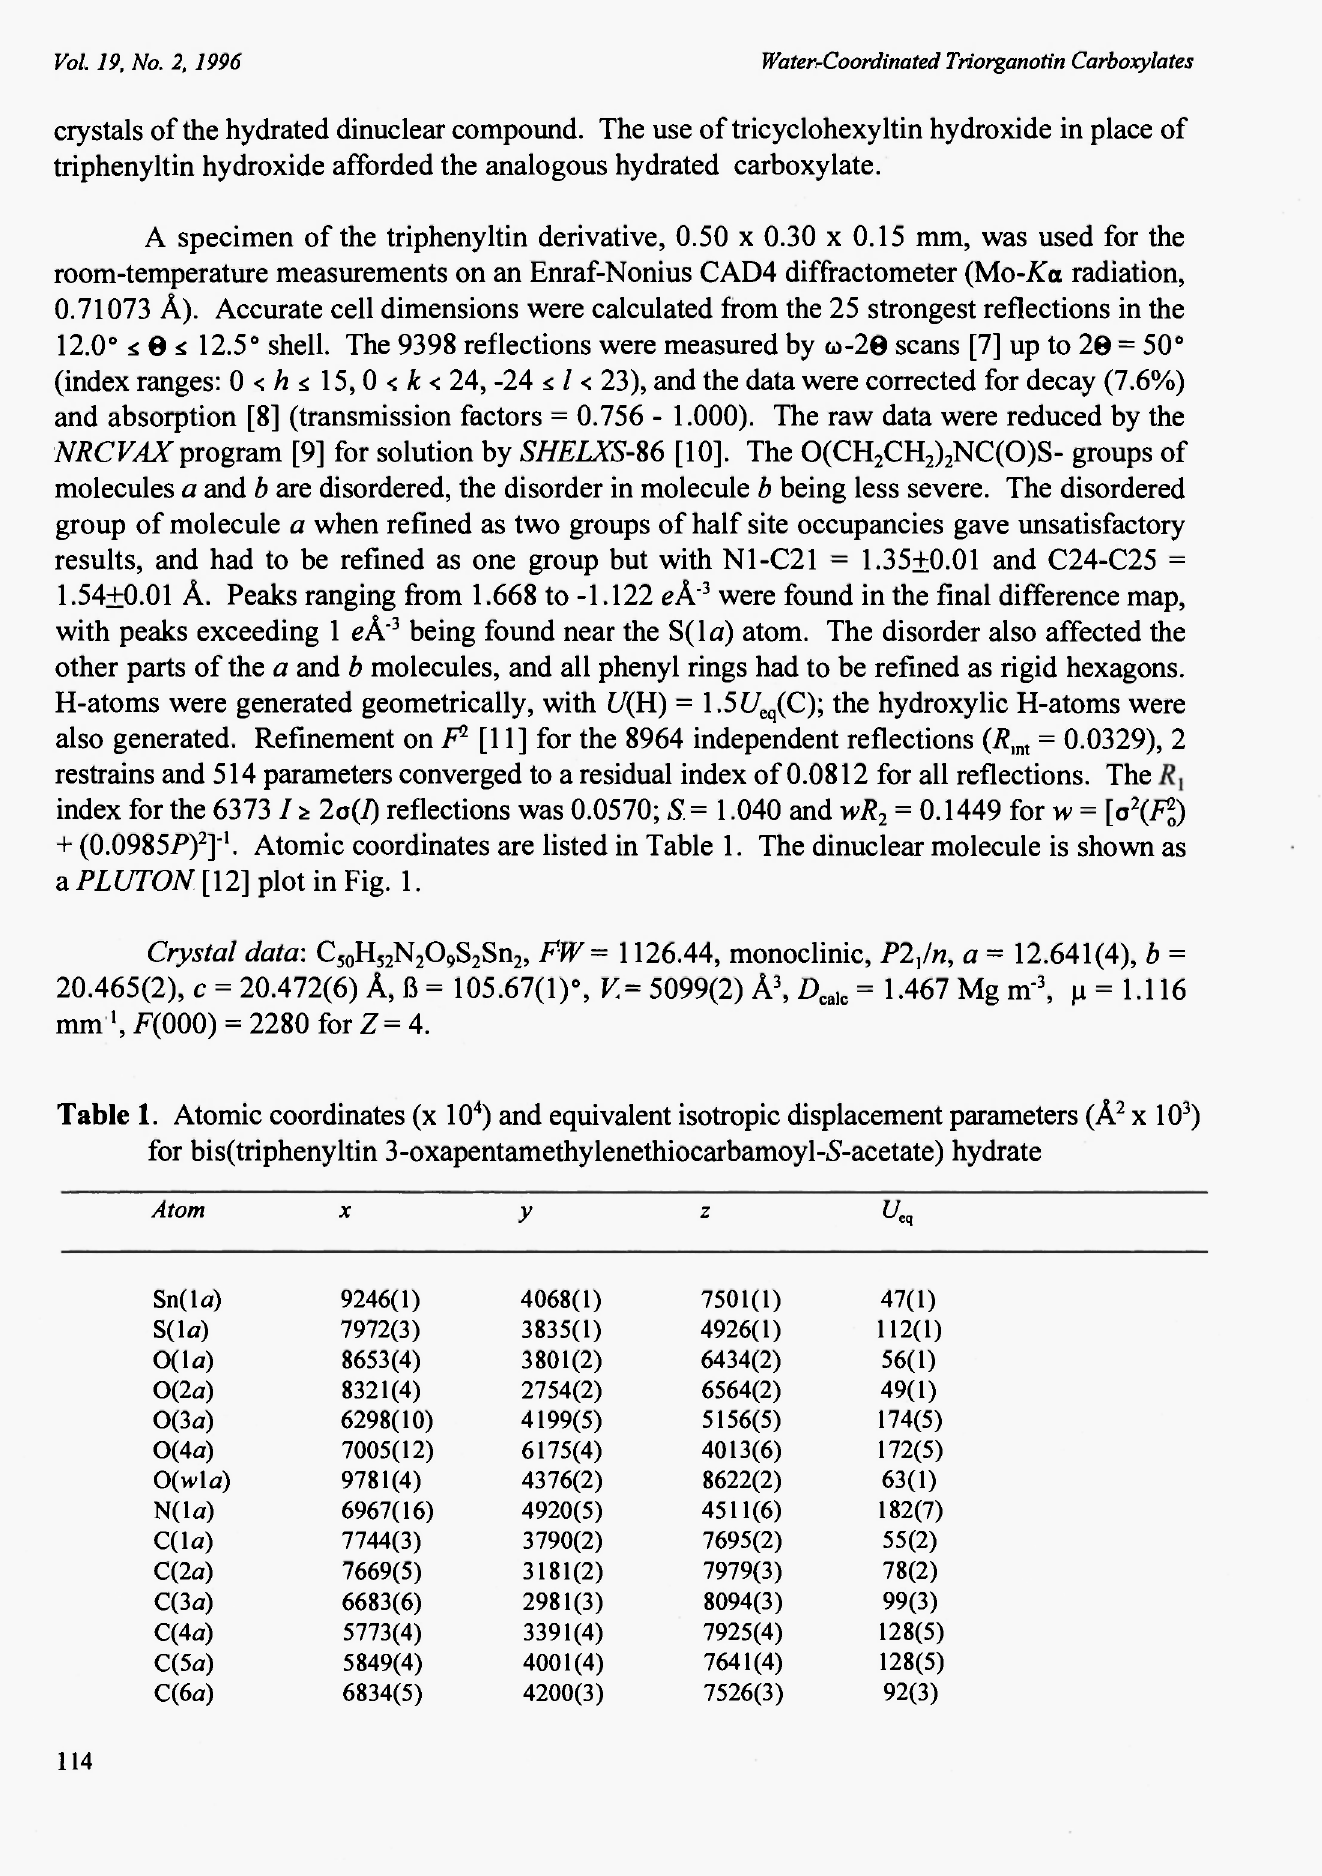
Table 1. Atomic coordinates (χ 10 4 ) and equivalent isotropic displacement parameters (Α 2 χ 10 3